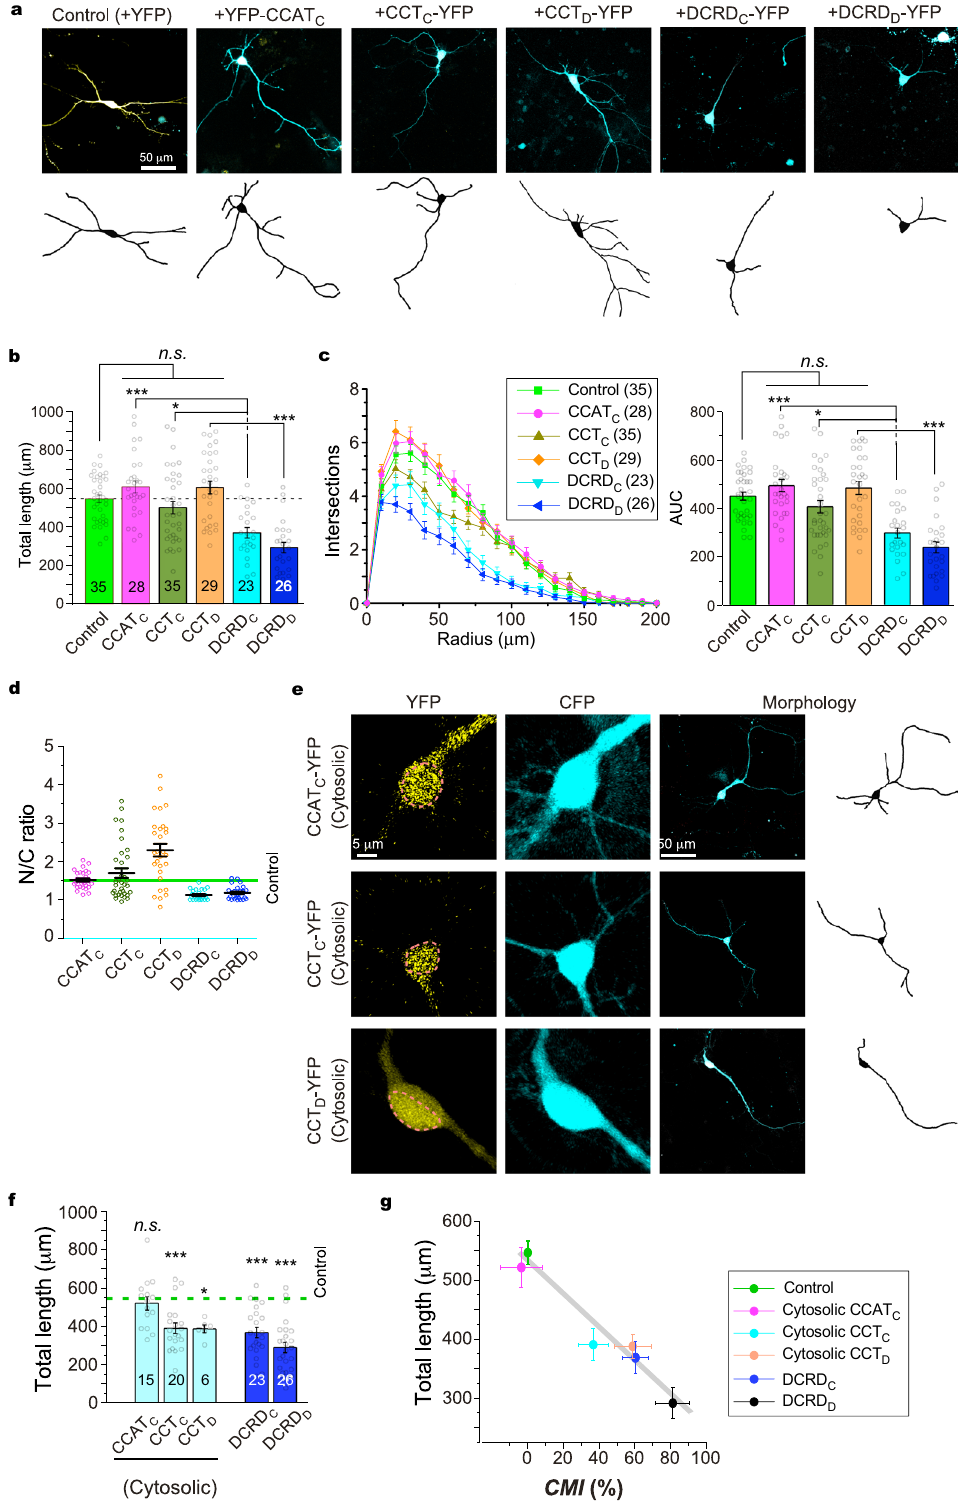
fl uorescence intensities through the donor cube) as the index of binding af fi nities. Utilizing CFP-tagged DCRD X peptides (X = S, D, C, and F representing Ca V 1.1-1.4) and YFP-tagged preIQ 3 -IQ D -PCRD D (CaM-binding motif of Ca V 1.3) as the FRET pairs, a series of binding curves were achieved by iterative fi tting processes (Fig. 4a). Among a gradient of K d values from the four pairs of binding, DCRD F encoded by Ca V 1.4